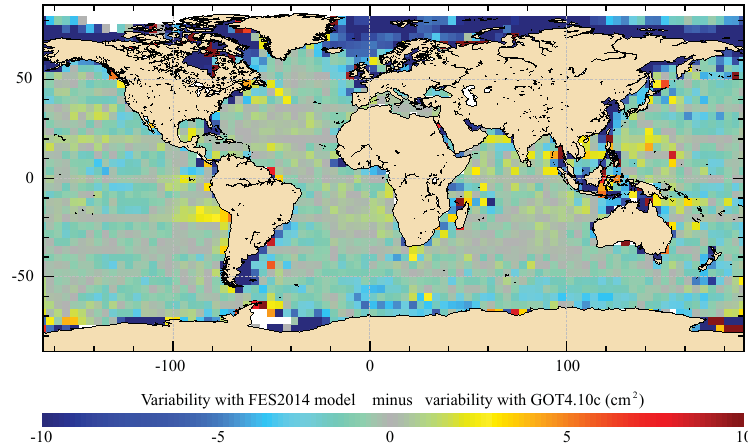
Figure 6. Change in crossover differences between processing Envisat mission with FES2014 tides or GOT4.10. Negative values indicate reduced variance with